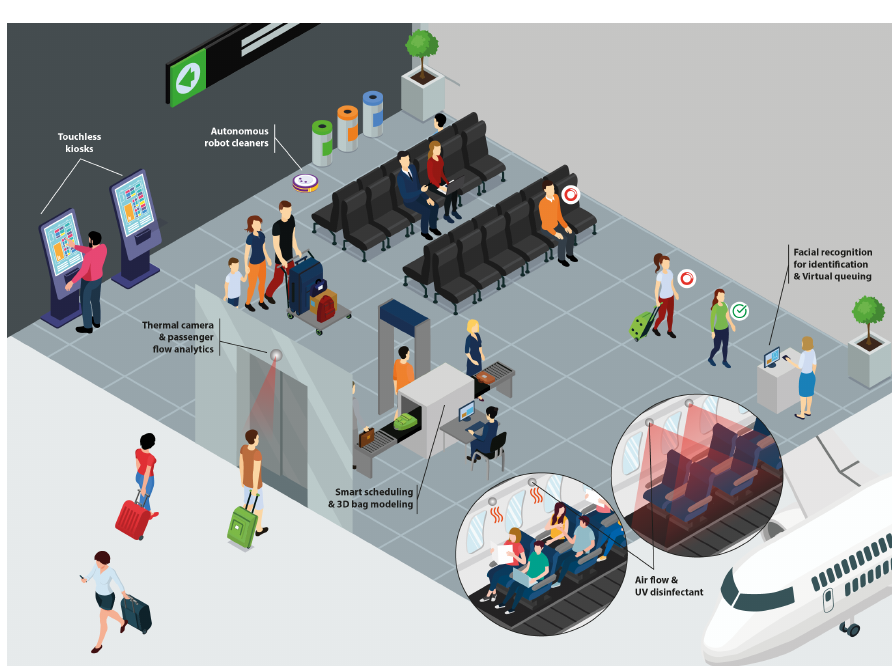
Figure 8. Invisible security zones use case: Invisible checkpoints for security in